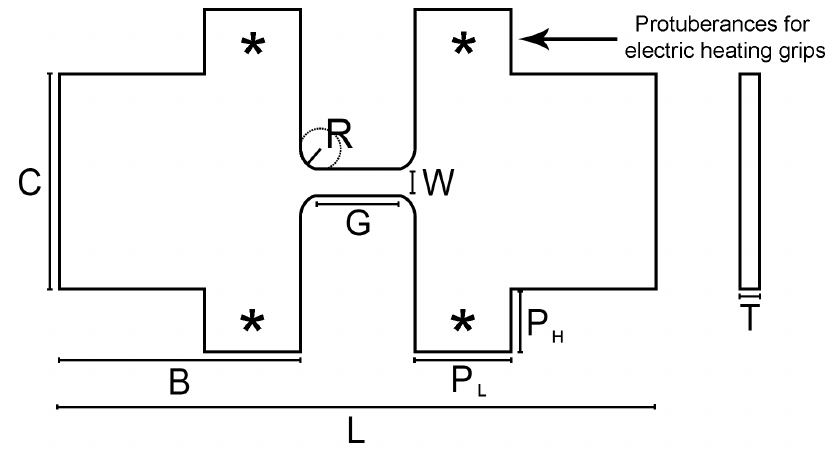
Figure 1. Specimen geometry used for the high-temperature tensile tests in the Split Hopkinson Pressure Bar. The asterisks indicate the protuberances for the electric heating grips. Table 1. Dimensions of the tensile samples (mm).